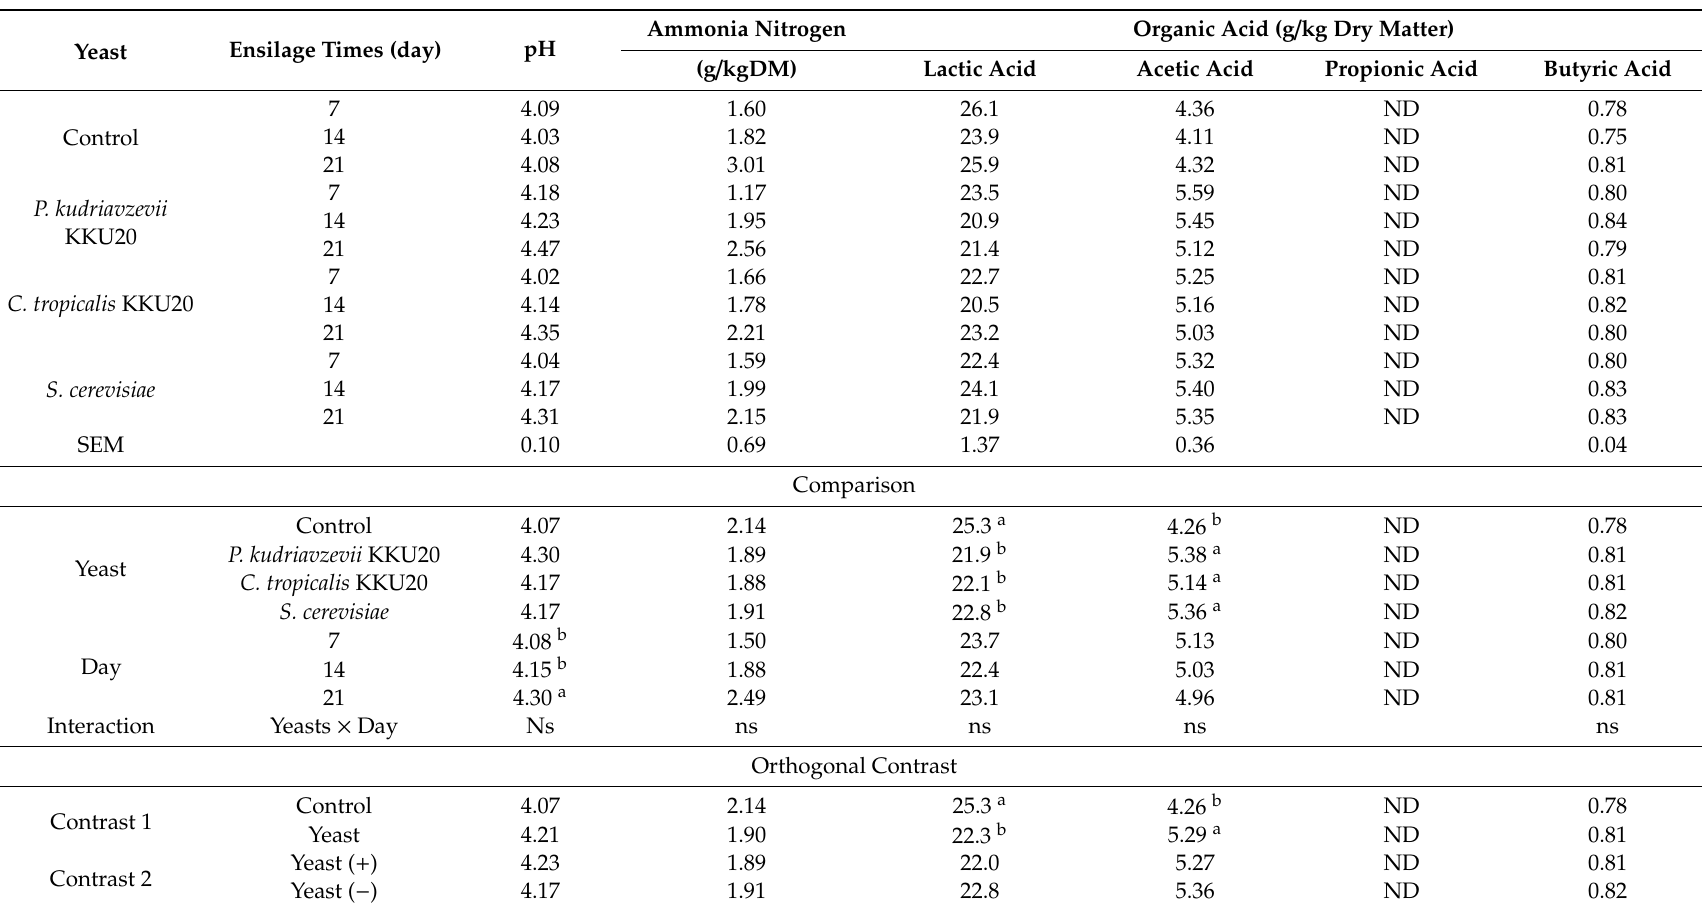
Table 3. Acidity (pH), ammonia–nitrogen, and organic acid composition in rice straw fermented with Crabtree-negative and -positive